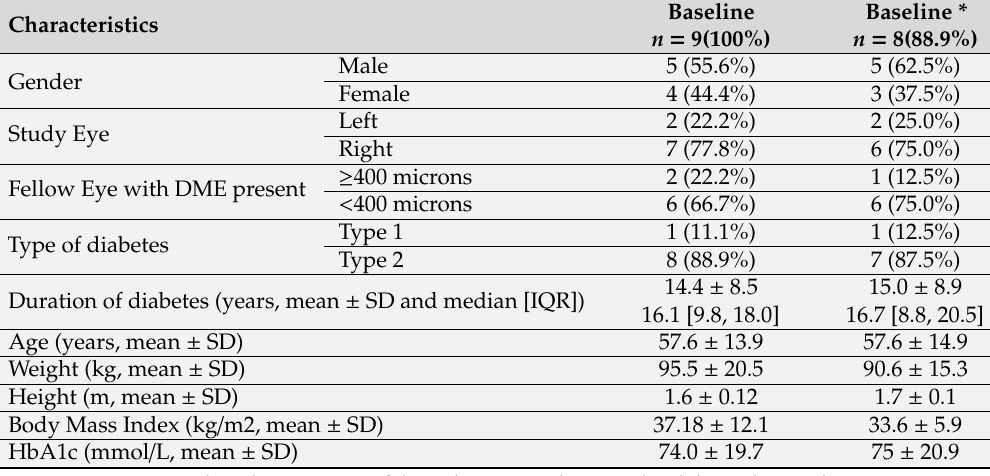
Table 1. Baseline characteristics of